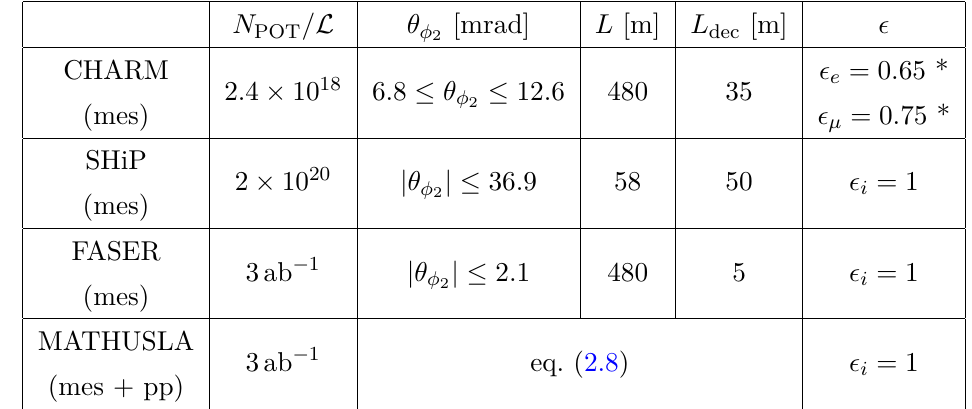
Table 2 . Specifications used for each experiment to compute the total number of φ 2 signals in the detector according to eq. (2.2): N POT is the number of proton on target (for CHARM and SHiP), L is the total luminosity of the experiment (for FASER and MATHUSLA), θ φ the direction of flight of φ 2 and the beam axis, L is the distance between the interaction point and the detector, L dec is the detector length and (cid:15) is the efficiency for detection of the φ 2 decay products. For each experiment we also specify the production mechanism for φ 2 that we have considered (mes = meson decays, pp = direct parton production). (*) In the case of the CHARM experiment the efficiencies must be multiplied by a factor 0 . 095 to take into account that the detector covers only 9 . 5% of the circular corona defined by the angular